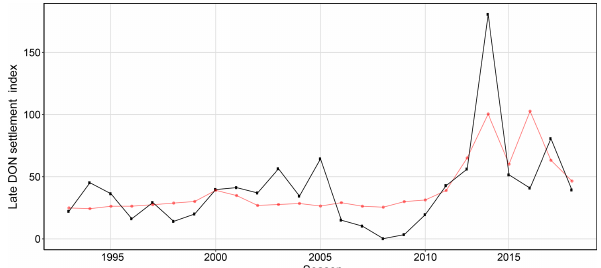
Figure 10. Observed (black) and modelled (red) late Dongara (DON) settlement index from 1993 to 2018. The red line is the most parsimonious model extended to